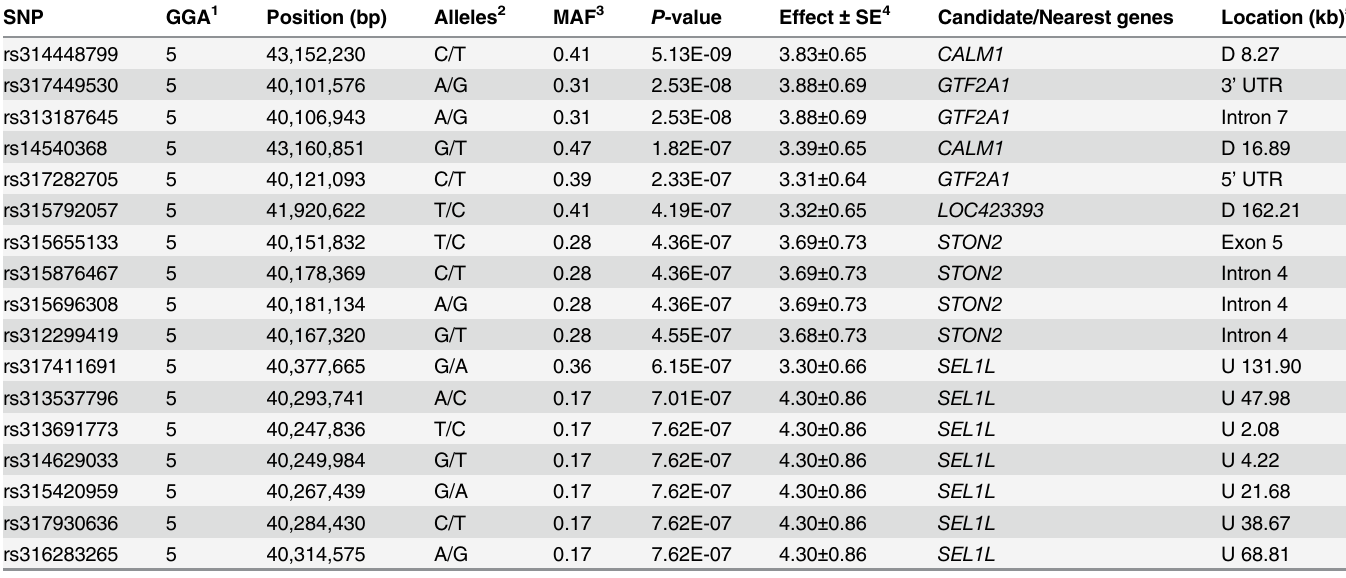
Table 6. The information for SNPs significantly associated with egg number between 21 and 40 weeks of age.